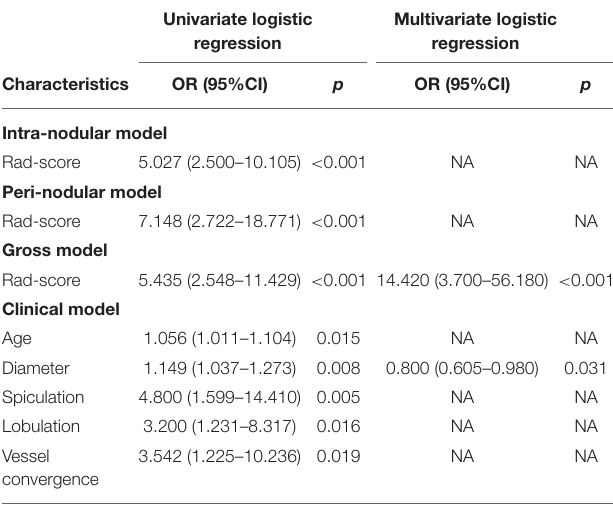
TABLE 3 | Risk factors for invasiveness of the ground-glass nodule (GGN) in the training set. Univariate logistic regression